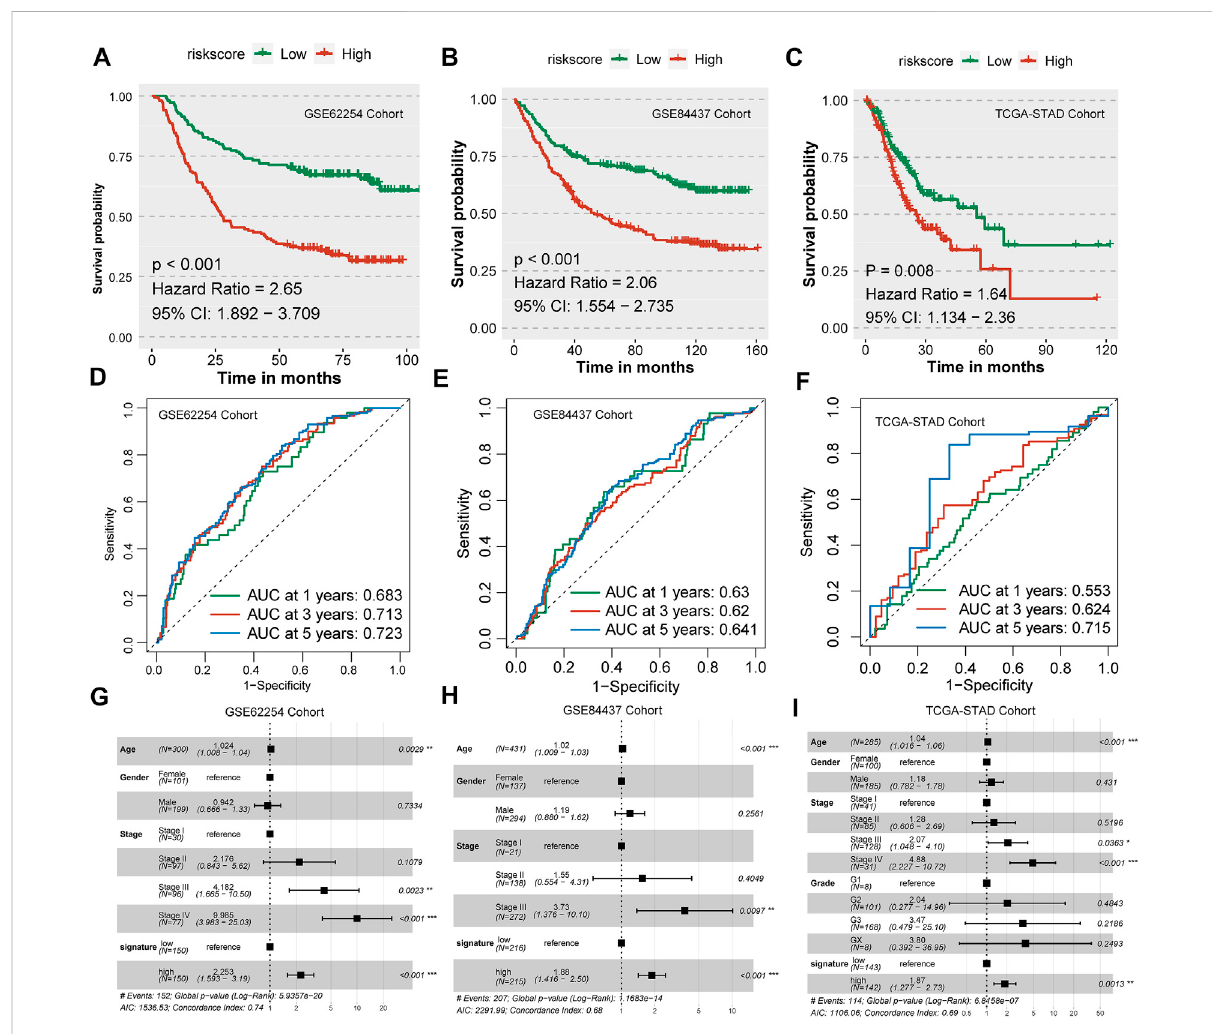
FIGURE 8 Validation of the nine-consensus-prognostic-gene signature in GSE62254, GSE84437 and TCGA-STAD cohorts. (A) , Kaplan – Meier curve for overall survival time of patients in the GSE62254 cohort; (B) , Kaplan – Meier curve for overall survival time of patients in the GSE84437 cohort; (C) , Kaplan – Meier curve for overall survival time of patients in the TCGA-STAD cohort; (D) , Time-dependent ROC curves showing the predictive ef fi ciency oftherisksignaturein theGSE62254cohort; (E) , Time-dependent ROC curves showing thepredictiveef fi ciency oftherisksignature in the GSE84437 cohort; (F) , Time-dependent ROC curves showing the predictive ef fi ciency of the risk signature in the TCGA-STAD cohort; (G) , Forest plot showing the hazard ratios from multivariate Cox regression analysis in the GSE62254 cohort; (H) , Forest plot showing the hazard ratios frommultivariateCoxregressionanalysisintheGSE84437cohort. (I) ,ForestplotshowingthehazardratiosfrommultivariateCoxregressionanalysis in the TCGA-STAD